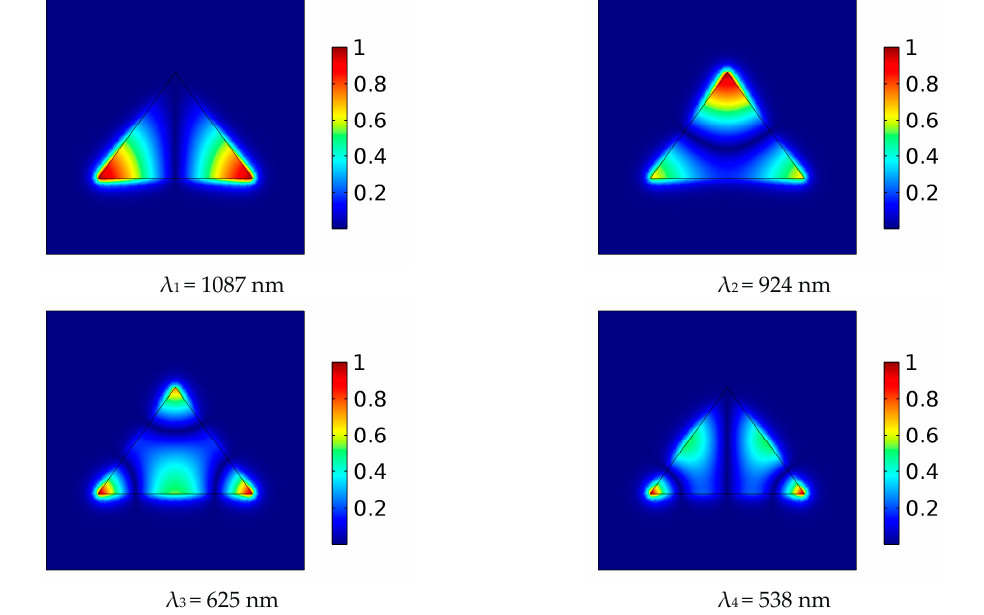
Figure 4. Normalized Hz field distribution at eigenmode resonant frequencies for isosceles triangular resonator.